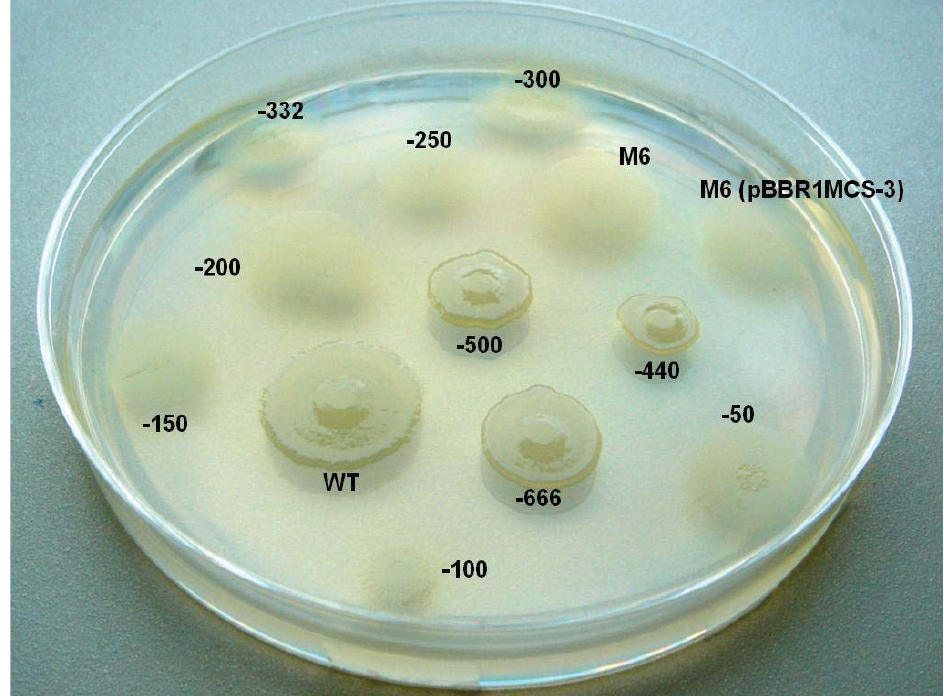
Figure A4. Phenotype of the lscBC -deficient mutant PG4180.M6 complemented with various lscB deletion constructs (ranging from -50 to -666-bp upstream of the translational start of lscB gene) and grown on MG agar supplemented with 5% sucrose. PG4180.M6 (pBBR1MCS) and PG4180.M6 served as negative controls. WT represents PG4180.WT serving as the positive